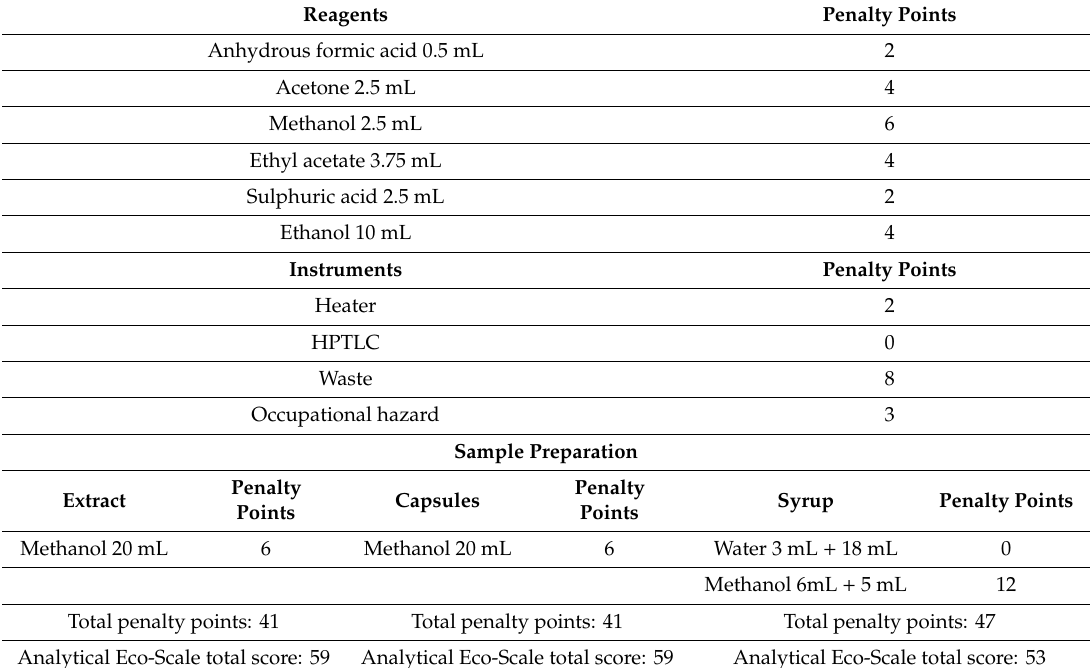
Table 7. Assessment of HPTLC method in the analysis of one